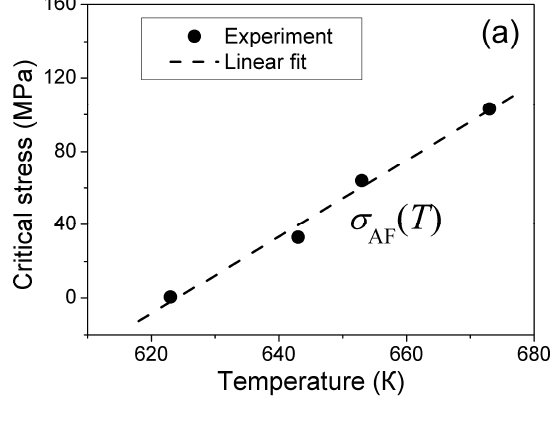
Figure 7. ( a ) Experimental stress values corresponding to the finish of reverse MT of Sample 1. ( b ) Experimental stress values corresponding to the start of forward MT of Sample